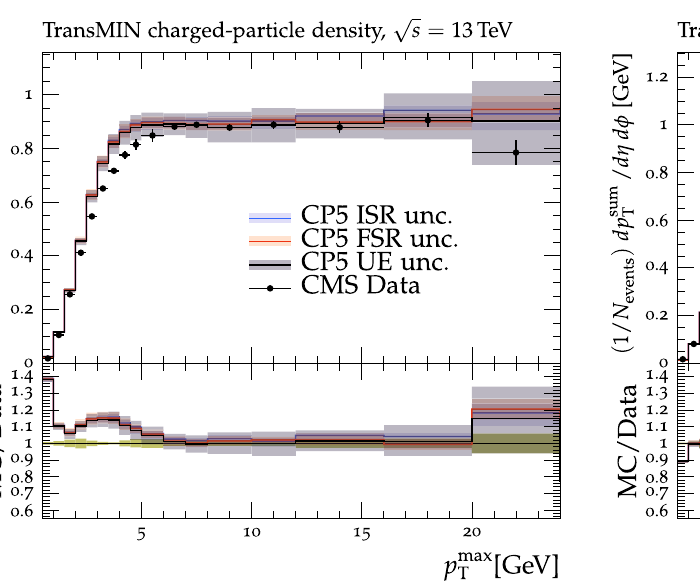
( m ) (blue total uncertainty in the data. The grey band represents the total UE Z S uncertainty for the tune CP5. Horizontal bars indicate the associated bin